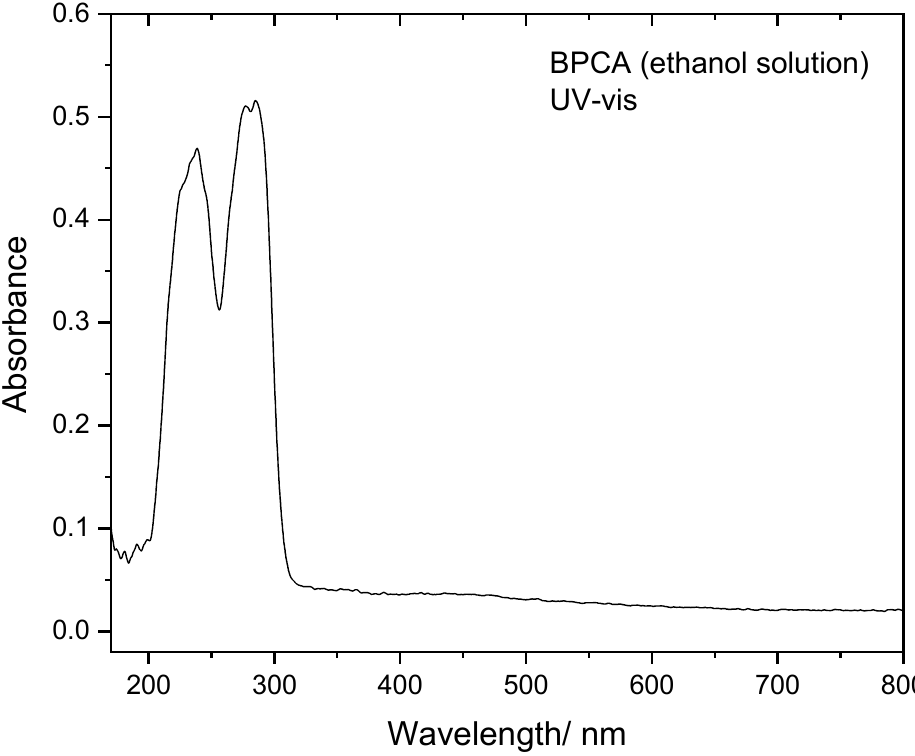
Figure 4. Room temperature UV–vis absorption spectrum of BPCA in ethanol solution (0.7 mM). Table 5. Vertical excitation energies, wavelengths, oscillator strengths and main contributions to the excited states of BPCA ( trans conformer) calculated at the TD-DFT(CAM-B3LYP)6-311+G(d,p) level in ethanol.